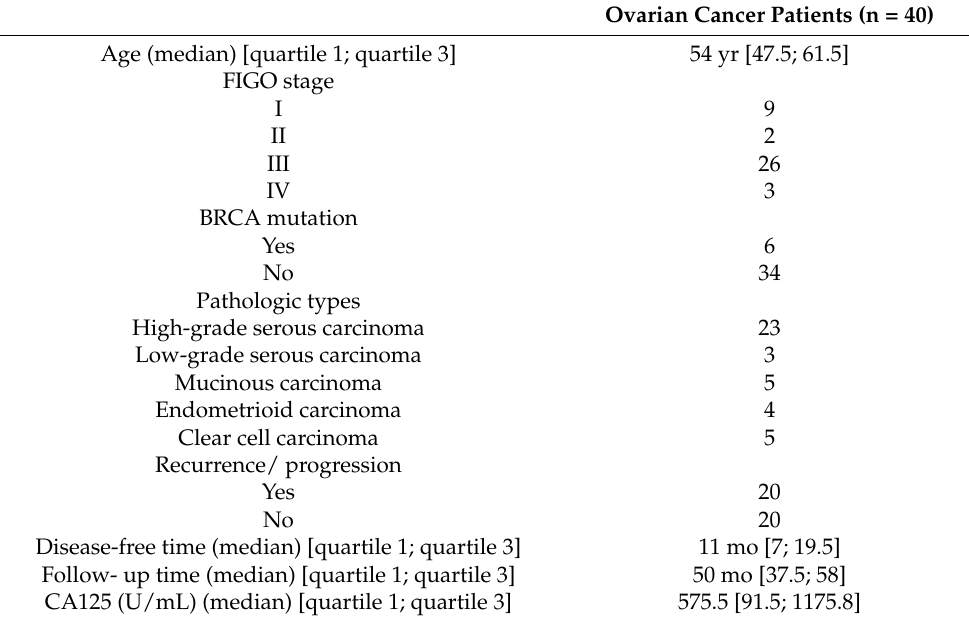
Table 1. Clinico-pathological characteristics of the ovarian cancer